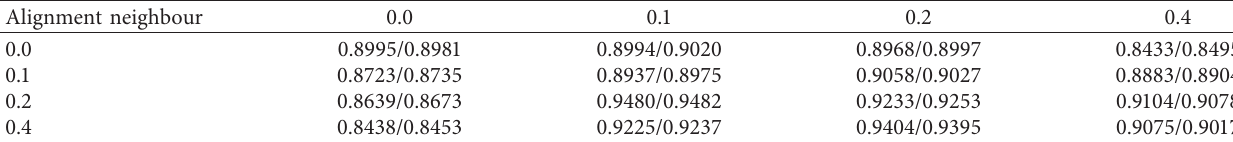
Table 6: Results (accuracy/ F 1-score) of multi-TW using different values of thresholds for ILE functions.